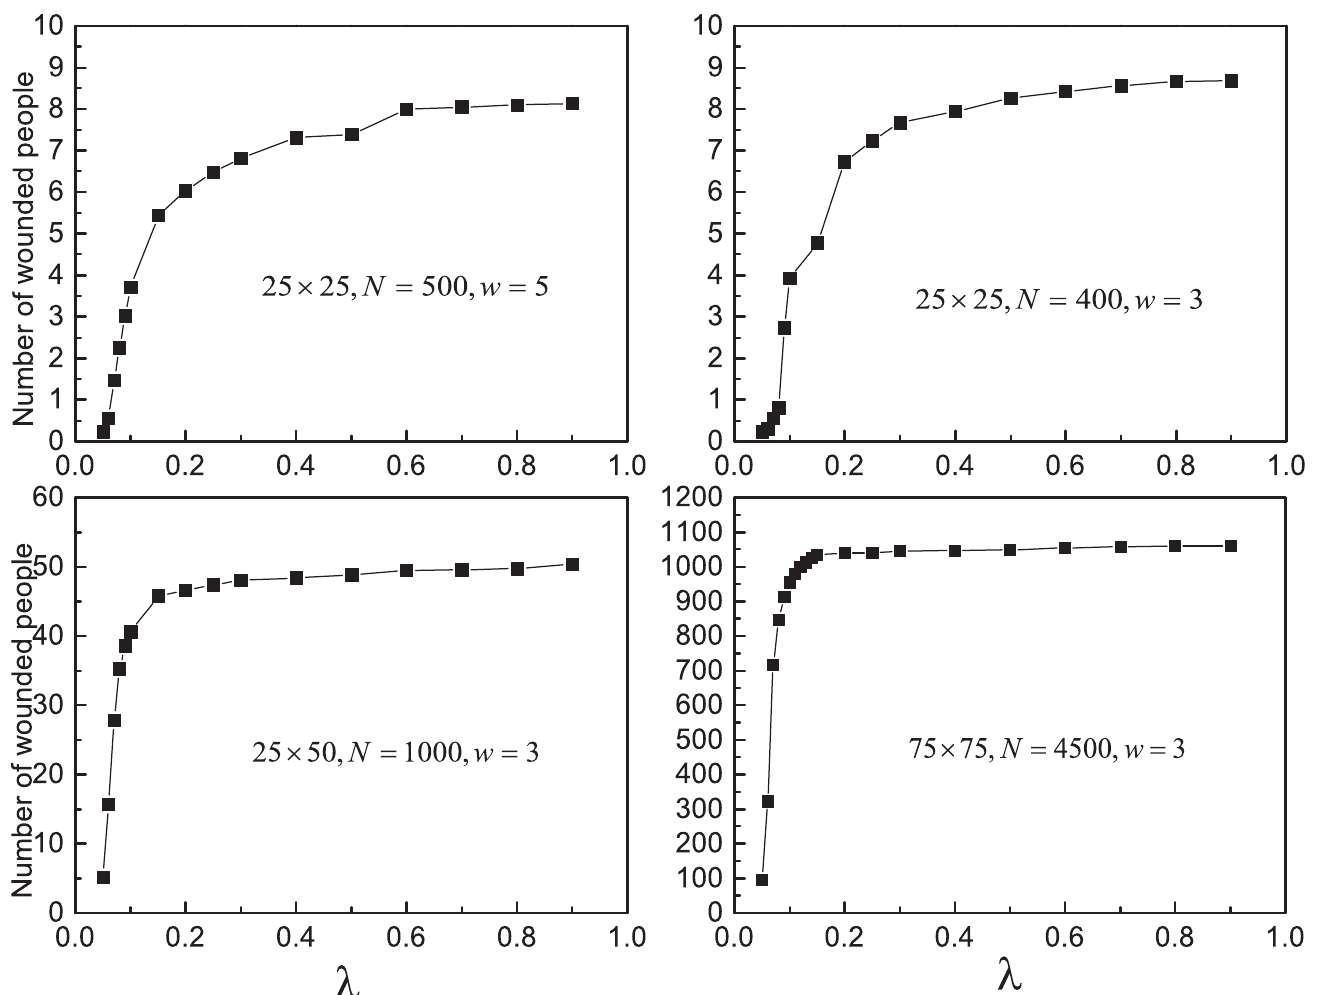
Fig 11. The number of wounded people as function of λ with various parameters. All the data points above are obtained by averaging over 500 different realizations. Initially, N II =